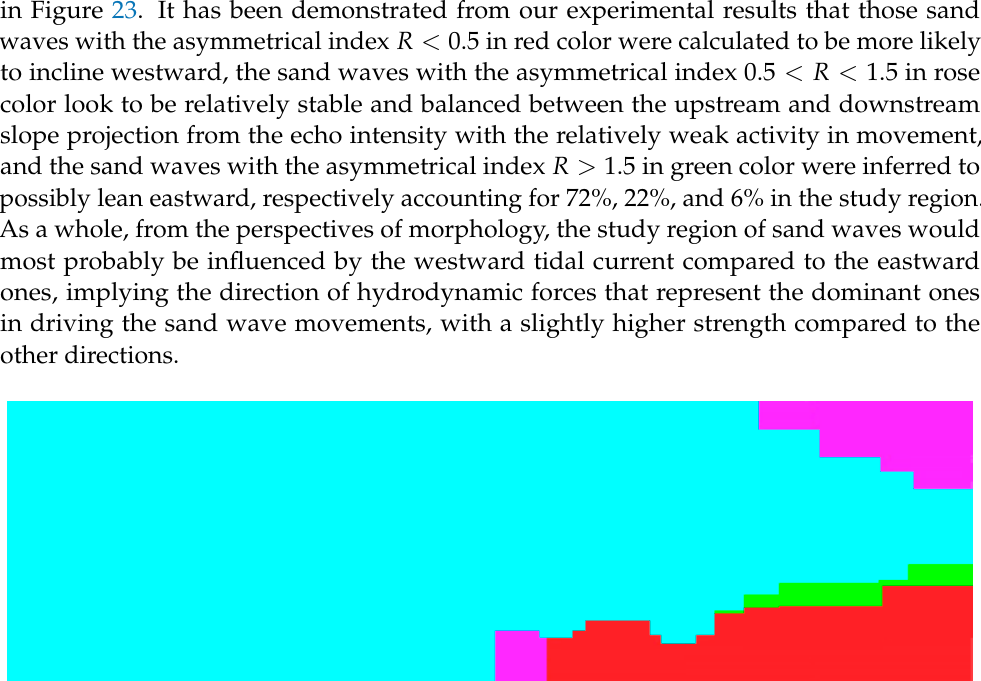
Figure 22. Asymmetric index definition.